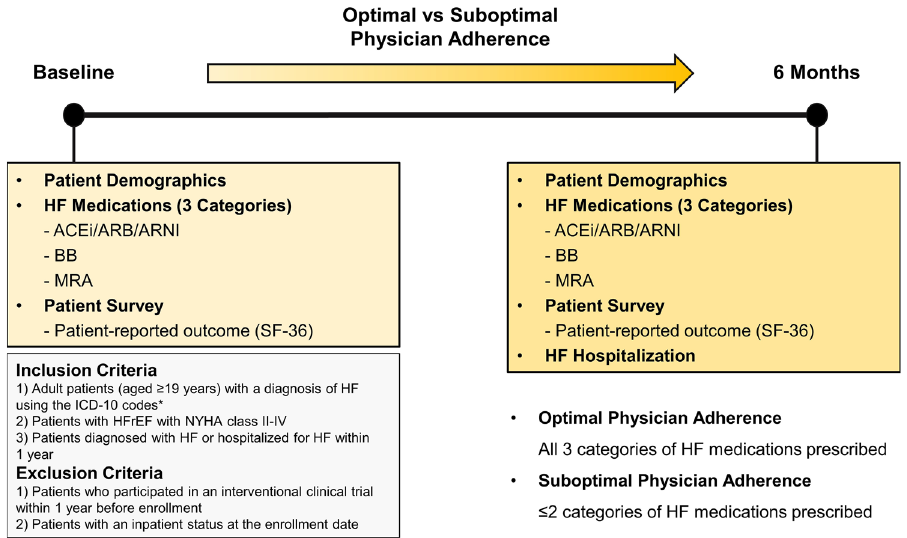
Figure 1. Schematic summary of the study design. ACEi, angiotensin-converting enzyme inhibitor; ARB, angiotensin receptor blocker; ARNI, angiotensin receptor-neprilysin inhibitor; BB, beta-blocker; HF, heart failure; HFrEF, heart failure with reduced ejection fraction; ICD-10, International Classification of Diseases 10th Revision; MRA, mineralocorticoid receptor antagonist; NYHA, New York Heart Association; SF-36, 36-Item Short Form Survey. *I50, I50.0, I50.1, I50.9, I11.0, I13.0, I13.2, I25.5, I42,